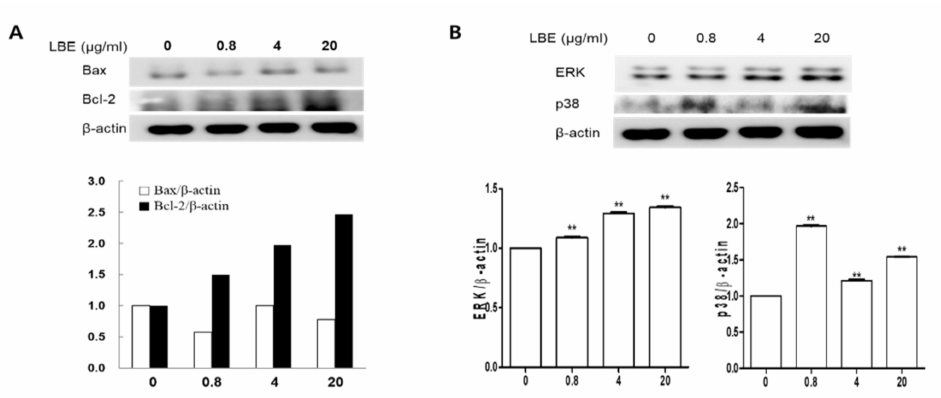
Figure 2. The effects of LBE on protein expression in DPCs. Western blot analysis of the protein levels of ( A ) Bax and Bcl-2, ( B ) ERK, and p38. Representative data for each group are expressed as mean ± SD. ** p < 0.01 compared with the control